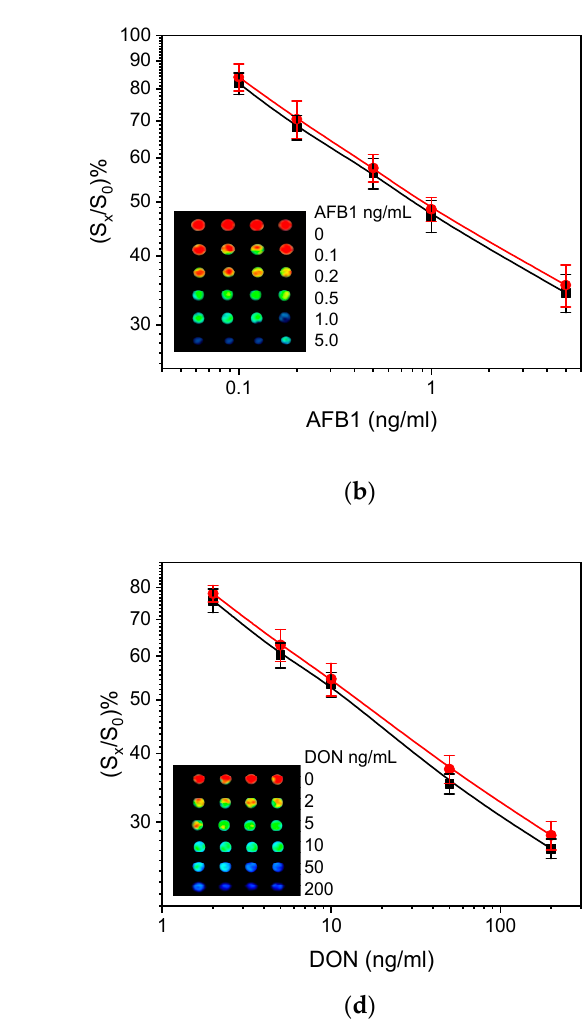
Figure 8. Typical calibration curves obtained with calibrators prepared in assay buffer (black squares) or 5-times diluted corn extract (red circles). Inserted into each graph are representative fluorescence images of the spots corresponding to the calibrator concentrations shown on the right of each image. Table 1. Analytical characteristics of the multiplex mycotoxin